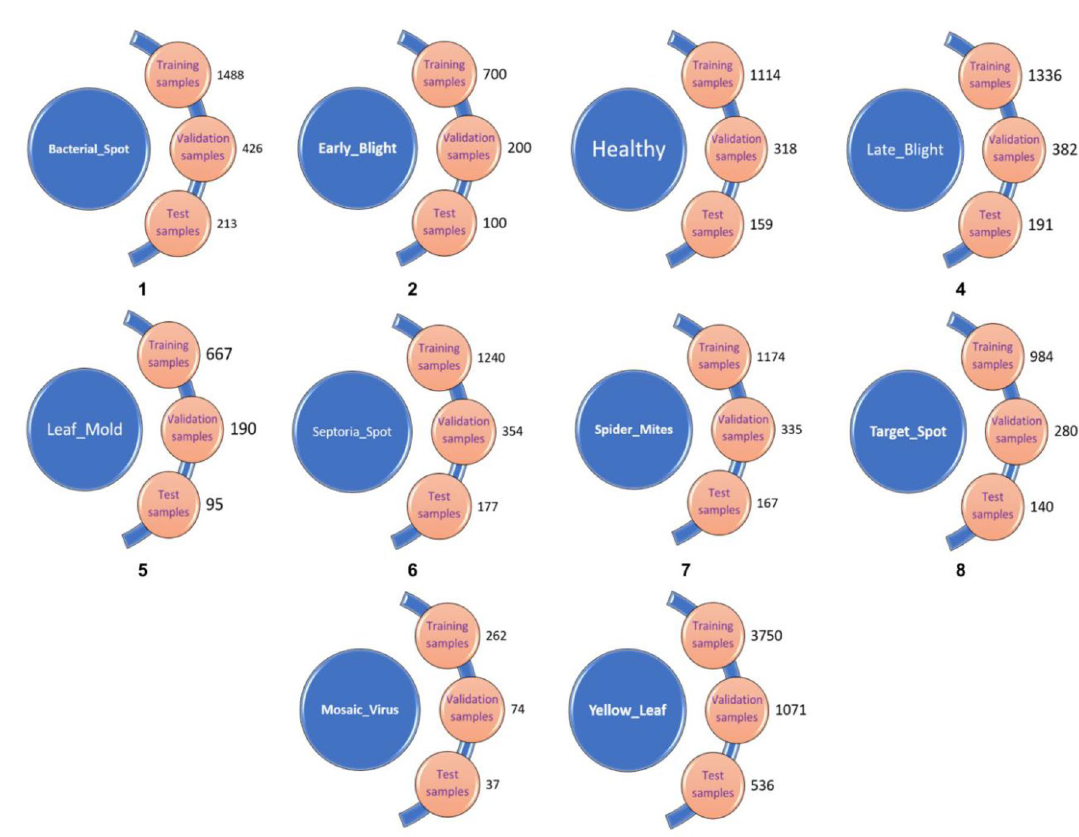
Figure 2. Detailed description of the employed